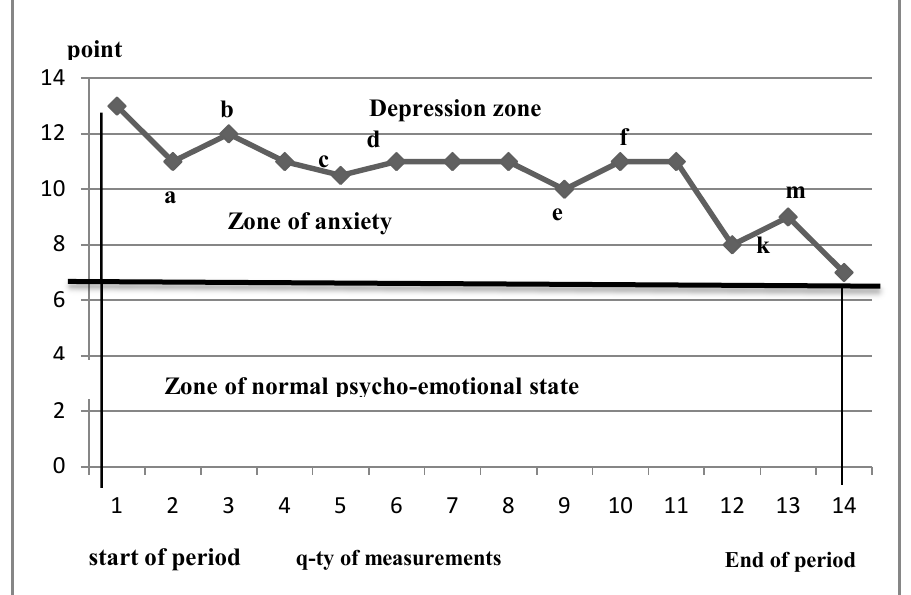
Fig.1. Diagram of testing of traumatized sportsman’s psycho-emotional